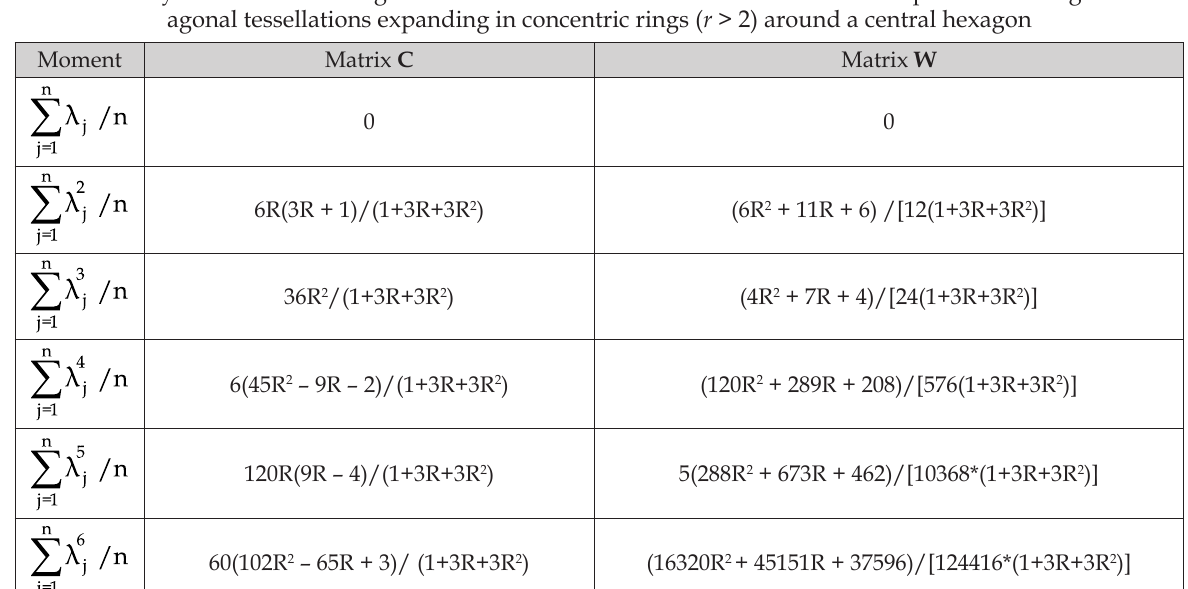
Table 3. Analytical moments of eigenvalues extracted from matrices C and W that depict selected regular hex -